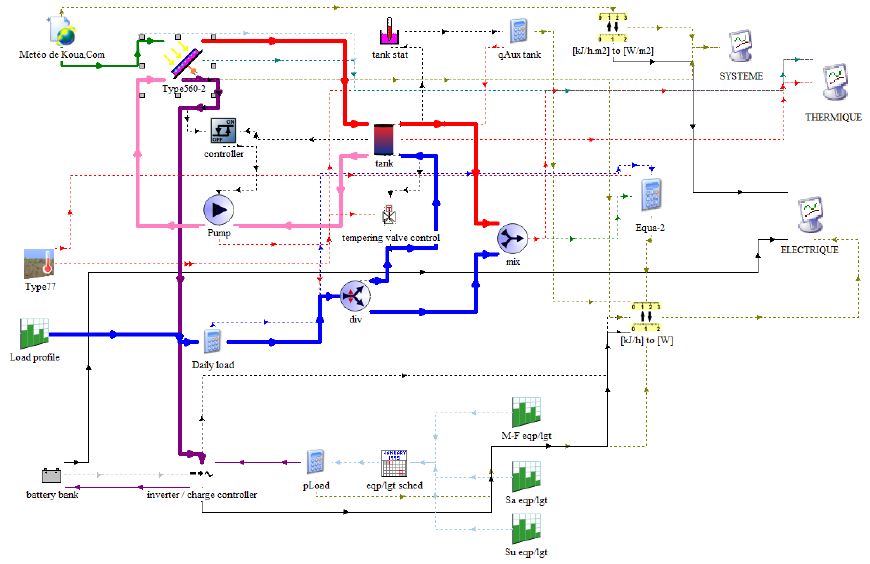
Figure 3. PV/T system simulator developed in TRNSYS.